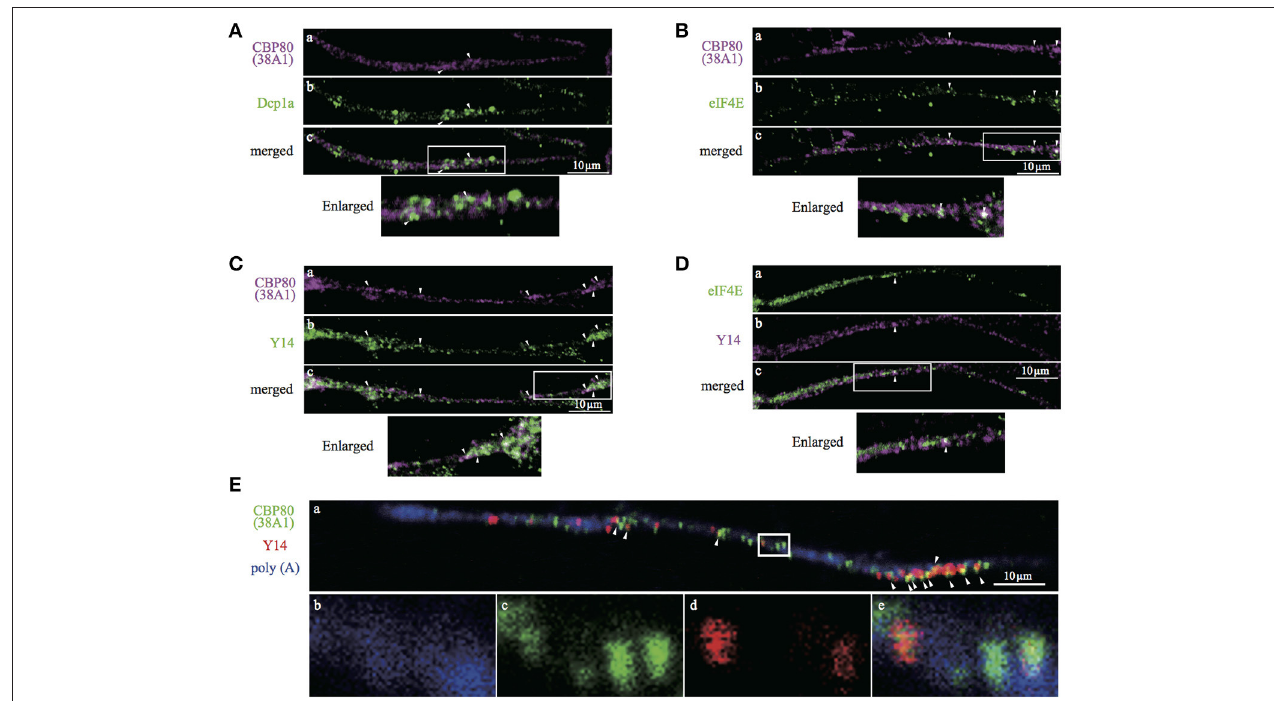
FIGURE 6 | Confocal images of iPS-derived dopaminergic neurons double- or triple-stained with antibodies against. (A) CBP80 ( a , magenta) and Dcp1a ( b , green), (B) CBP80 ( a , magenta) and eIF4E ( b , green), (C) CBP80 ( a , magenta) and Y14 ( b , green), (D) eIF4E ( a , green) and Y14 ( b , magenta), (E) poly(A) RNA ( a,b , blue), CBP80 ( a,c , green), Y14 ( a,d , red). Merged images are also presented as (c) and (e) . Scale bars, 10 µ